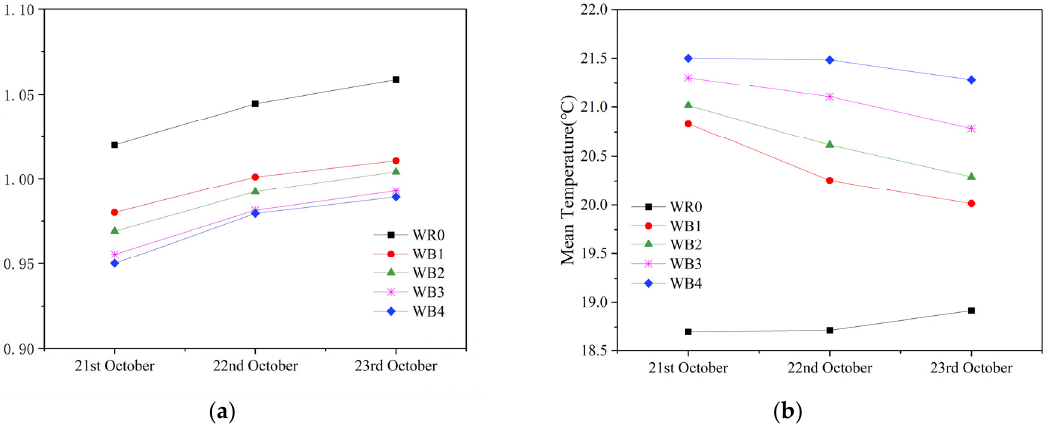
Figure 4. Variations in ( a ) daily mean water level and ( b ) daily mean temperature of the river water and the groundwater over the monitoring period from 21 to 23 October 2021.